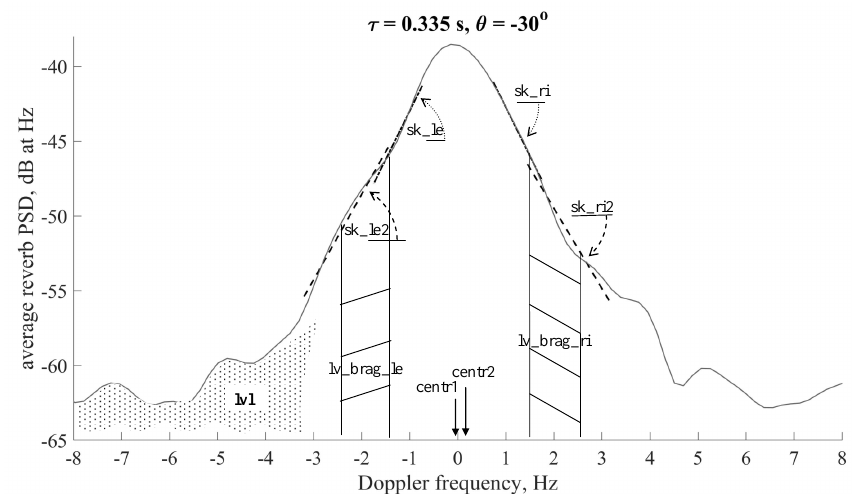
Figure 5. An example of the scattering spectrum with a sketch, explaining how it can be described by the selected set of